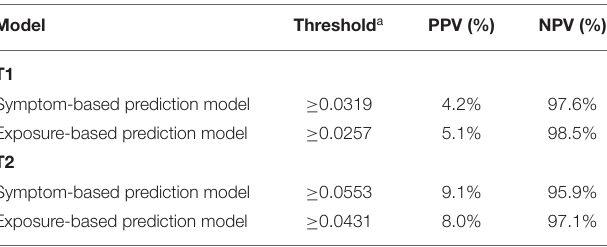
TABLE 4 | Positive and negative predictive values of the symptom- and exposure-based prediction models based on optimal threshold determined by the highest Youden’s